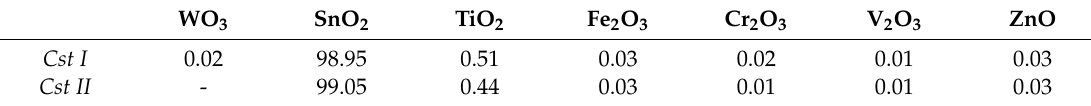
Table 6. Elemental median concentration values (wt %) characterizing Cst I and Cst II